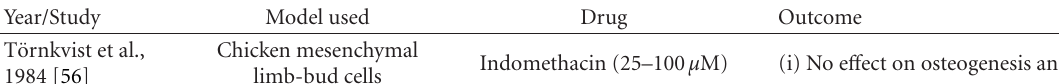
Table 1: In-Vitro Studies BM: Bone marrow, TB: Trabecular